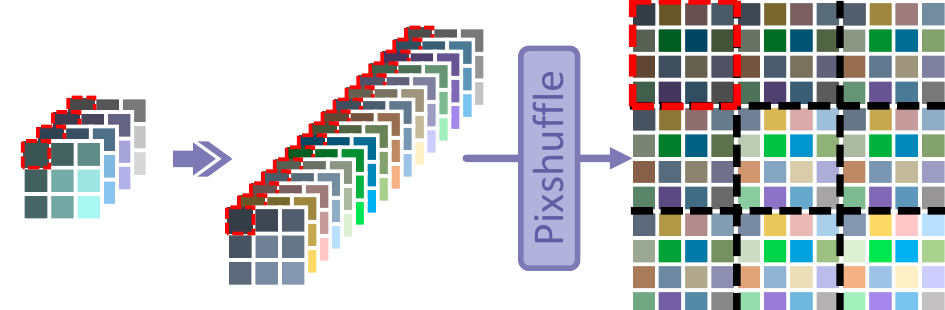
Figure 2. The base upsampling module in most related works. SD is displayed as a feature map with 4 channels to represent that each block is sampled into 4 measurements, and then it is upsampled and expanded into 16 channels, which is marked as the purple arrow. After that, the feature map is stretched into the same shape as the ground truth X by pixelshuffle [34]. The image is processed separately block by block, which is shown and divided by the black dotted line. For example, the SD marked by the red dotted line is just processed and stretched into the block in the upper left corner of the image by itself.